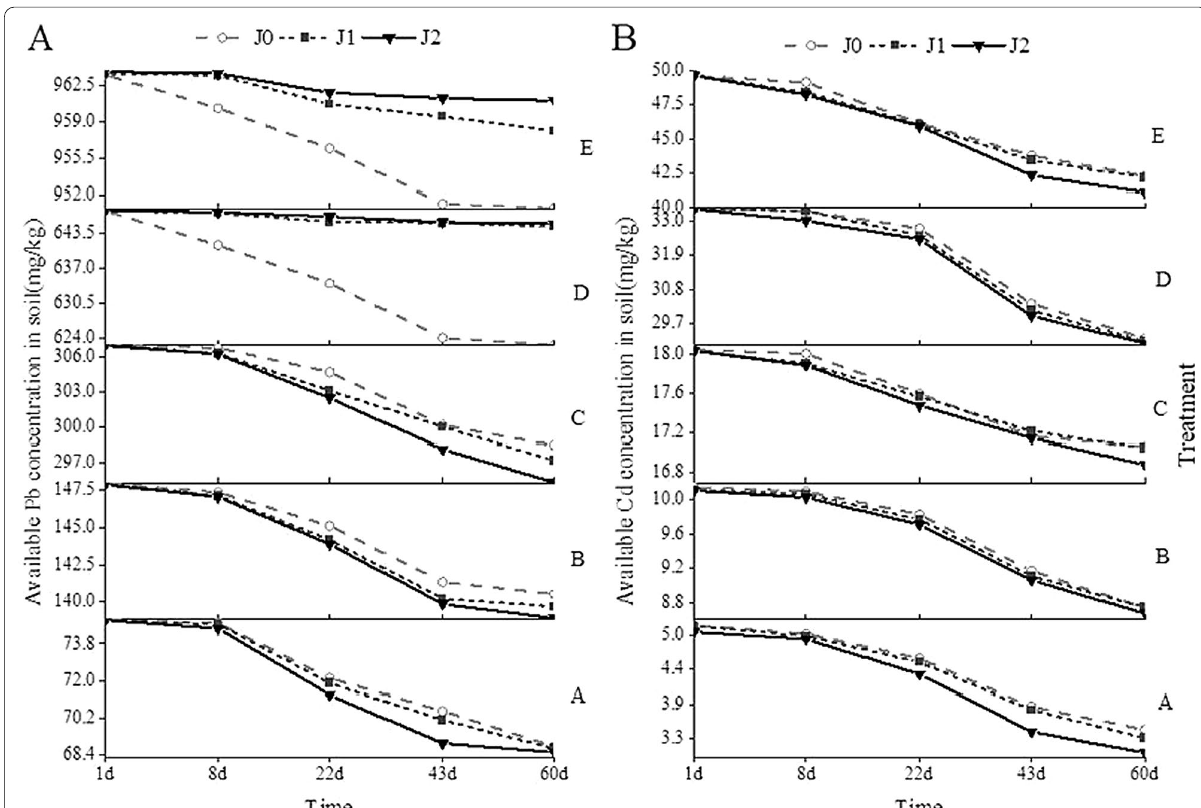
Fig. 3 Processes of soil effective state Pb and Cd content from day 1 to day 60 under different Pb and Cd concentration treatments. This figure shows the variation of Pb and Cd concentration in soil from day 1 to 60. Left graph ( A ) is the change process of soil available Pb content with time in each treatment; right graph ( B ) is the change process of soil available Cd content with time in each treatment. J0 represent no bacterial suspension, J1 means adding 100 ml bacterial suspension and J2 means adding 200 ml bacterial